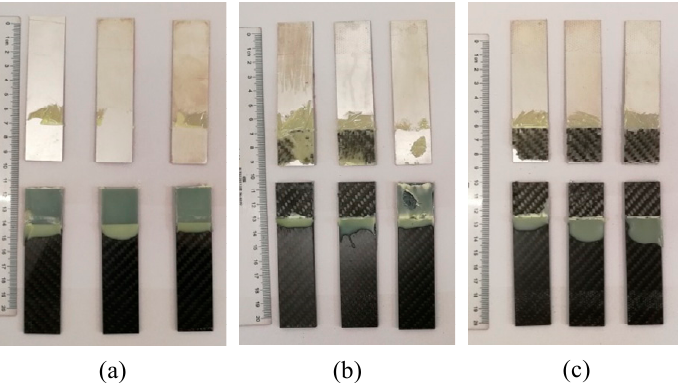
Figure 8. Damaged adhesive layer by tensile test of the samples in ( a ) Group 1, ( b ) Group 2, and ( c ) Group 3.